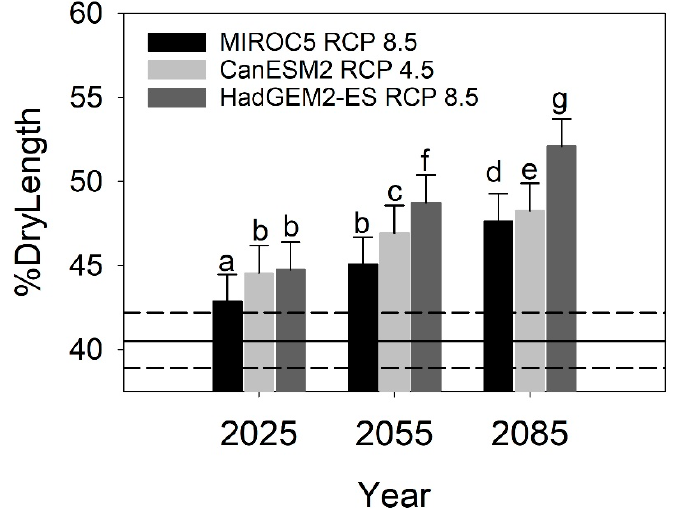
Figure 8. Future percent dry stream reach lengths in years 2025, 2055, and 2085 estimated from projected summer heat-moisture index (SHM), mean minimum summer temperature (Tmin sm), and basin area using multivariate modeling results (Table 6). Shaded bars show effects of MIROC RCP 8.5, CanESM2 RCP 4.5 and HadGEM2-ES RCP 8.5 scenarios. Reference line shows the recent climate result from SHM and Tmin sm in 1961–1990. Error bars show 95% confidence intervals. Differences in letters indicate significant differences between scenarios ( p < 0.05).